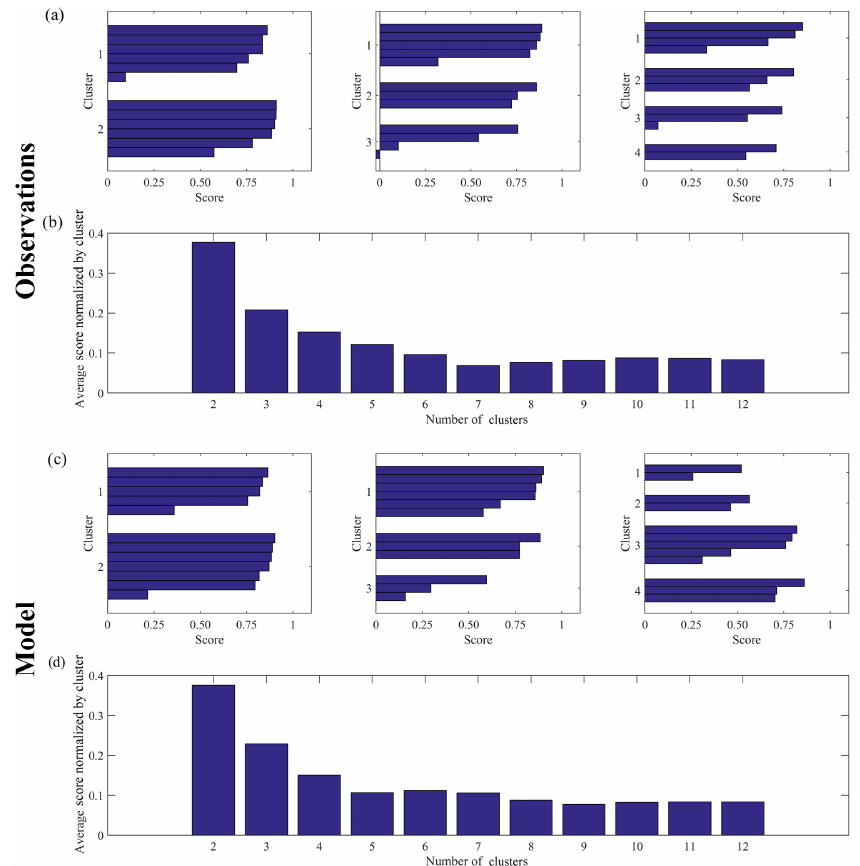
Figure 11. (a) Scores for each cluster analysis for k = 2, k = 3, k = 4 for the observational data in the Southern Ocean where cluster k is the predetermined number of clusters and each bar represents the score per 2-D histogram. (b) Average scores of each clustering analysis for increasing k , from k = 1 to k = 12. (c) Scores for each cluster analysis for k = 2, k = 3, k = 4 for the model data in the Southern Ocean. (d) Average scores of each clustering analysis for increasing k